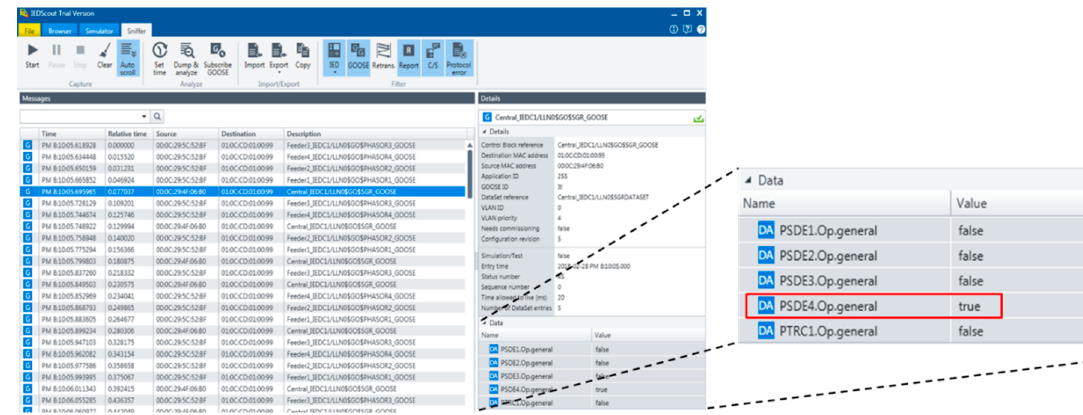
Figure 12. Generic Oriented Object Substation Event (GOOSE) messages sent when an SLG fault developed in the fourth feeder with a fault resistance of 0 k Ω . Table 2. Test results for SLG faults in the fourth feeder with different fault resistances.